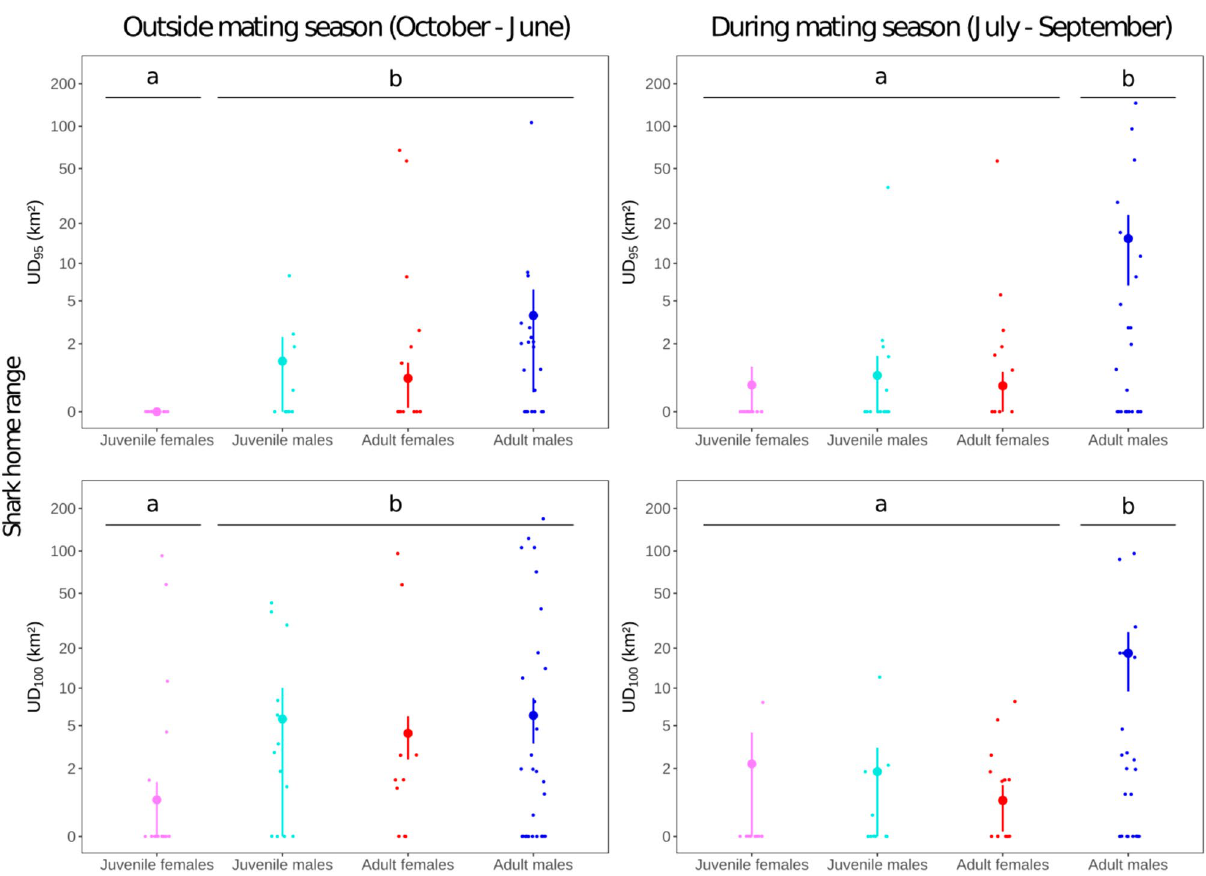
Figure 2. Comparison of home range for grey reef shark adults and juveniles during and outside mating season. UD 95 and UD 100 values represent the surface of outer reef slope habitat encompassed by the 95th and 100th percentile of daily positions. Large dots and bars indicate group means and their bootstrapped 95% confidence intervals. Significance of difference between group means were assessed with pairwise permutation Student tests and displayed with lower case letters. Graphics generated with R package ggplot2 (https:// ggplo t2. tidyv erse. Outside the mating season, home range did not significantly vary among sexes (UD 95 : p value = 0.07; UD 100 : p value = 0.882). However, maturity stage had a significant effect on UD 100 during this season ( p value = 0.003), with adults showing a significantly higher home range than juveniles (Table 1). During the mating season, both sex and maturity stages had significant effects on both home range metrics (UD 95 : sex p value = 0.003, maturity stage p value = 0.004; UD 100 : sex p value < 0.001, maturity stage p value = 0.003), with adult males showing sig- nificantly higher home ranges than adult females and juveniles of both sexes (Fig. 2). Removing the six long-range adult male migrators from the analyses showed similar results (Table S2). Cumulative curves of UD 95 and UD 100 values highlighted that 93% (95% bootstrapped-CI: 89–97%) and 76% (95% bootstrapped-CI: 69–83%) of sampled sharks had UD 95 and UD 100 values lower than 10 km 2 of reef, respec- tively. When considering adult males only, respectively 83% (95% bootstrapped-CI: 74–94%) and barely half of individuals (54%; 95% bootstrapped-CI: 43–66%) had UD 95 and UD 100 values lower than 10 km 2 of reef (Fig. S5). MPAs ability to cover sharks’ home range. Cumulative curves of UD values were then used to model the proportion of sharks whose home range could be fully covered by an MPA of a given size, considering a homogeneous distribution of individuals in the area (Fig. 3A). The model indicates that old MPAs of New Cal- edonia (created before 2010) were unable to cover the home range of grey reef sharks. For instance, the model shows that an MPA with the size of Aboré (a total area of 150 km 2 but only covering 10 km 2 of outer reef slope habitat) would be able to fully cover the UD 95 for 84% of sharks, and the UD 100 for 59% of sharks only (Table S3). These proportions dropped to 68% for UD 95 and 37% for UD 100 when considering adult males only. However, newly created MPAs of D’Entrecasteaux atolls and of Chesterfield and Bellona atolls, covering respectively 80 km 2 and 1130 km 2 of outer reef slope habitat (for a total area of 3500 km 2 and 27,150 km 2 , respectively), would encompass the UD 100 for 78% and 98% of adult males, respectively. In the Indo-Pacific, such very large MPAs, able to protect the home range of adult male grey reef sharks, were rare and mostly created recently (Fig. 3B). Indeed, our model indicates that only MPAs covering more than 95 km 2 of reef can achieve the ambitious management objective of protecting the home range (UD 100 ) of 80% of adult males. Only 26 out of the 622 Indo-Pacific MPAs exceeded this threshold. These 26 MPAs were all created